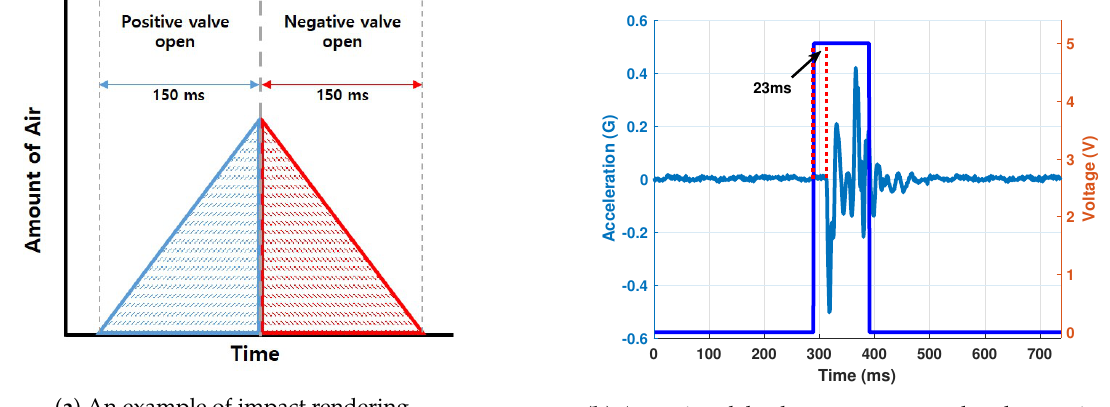
Figure 6. Quantitative analysis of impact response by haptic